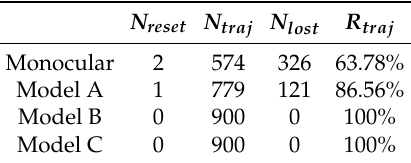
Table 9. The result of monocular mode and binocular mode in